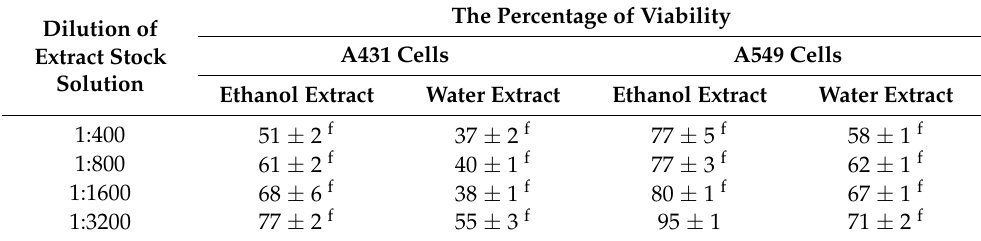
Table 3. Effect of plant extracts on growth of tumor cells